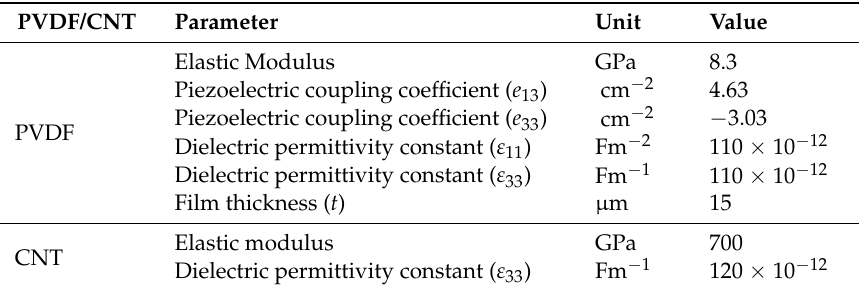
Table 1. Parameters for CNT/PVDF nanocomposites cited.